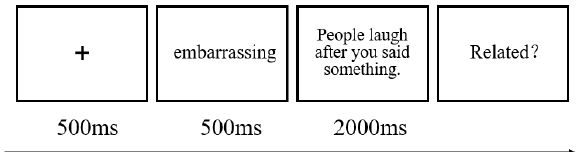
Figure 5. An illustrative example of the interpretation bias experiment.